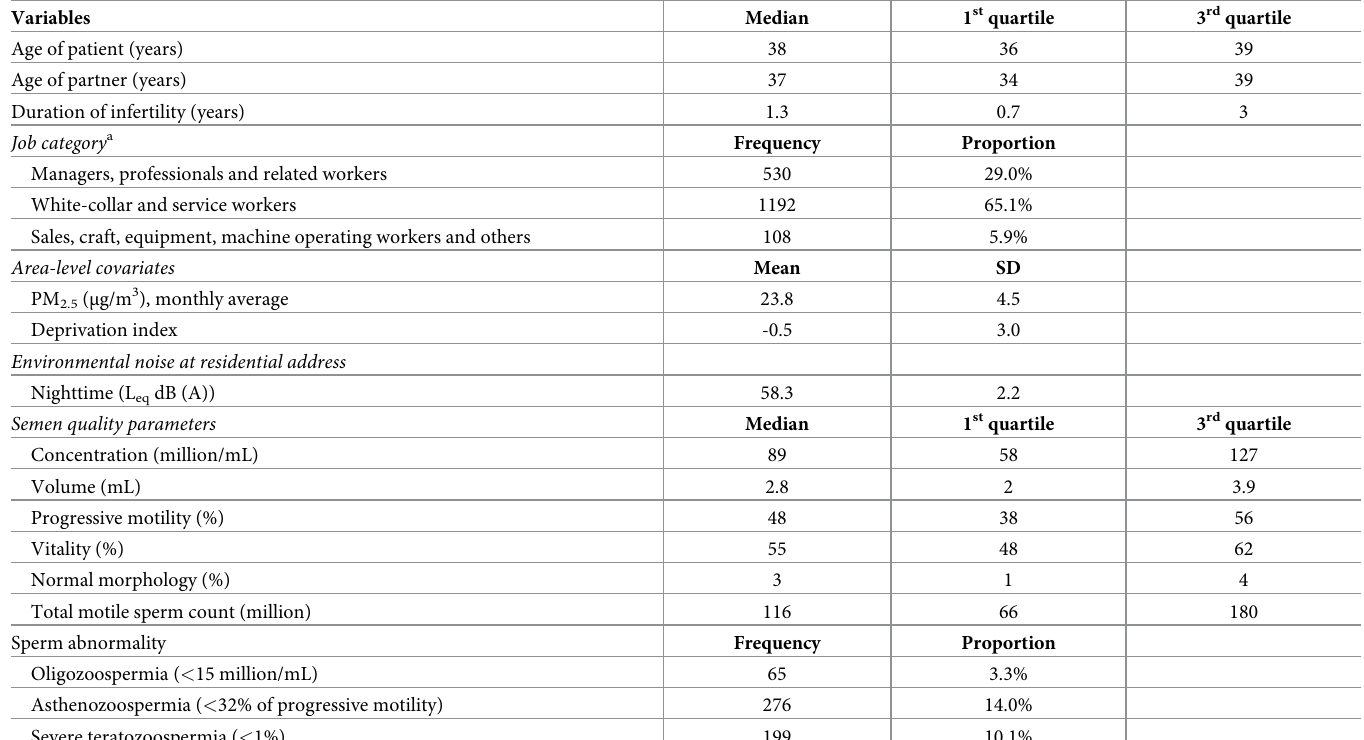
Table 1. Characteristics of study population (N = 1,972).